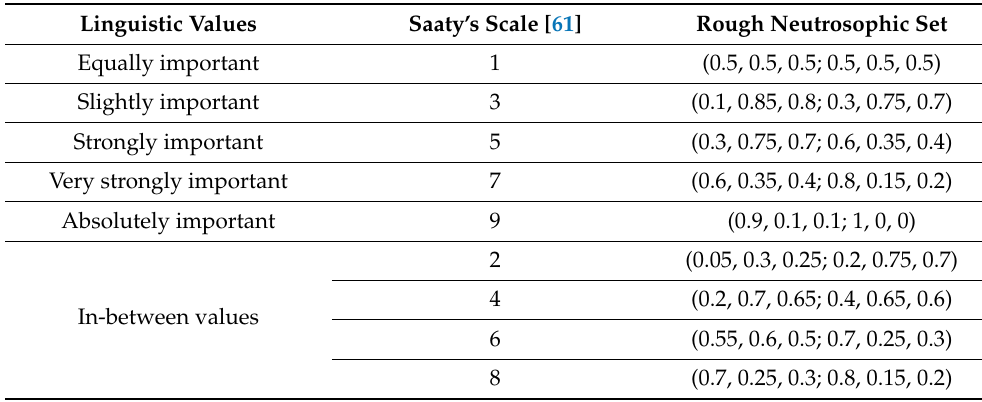
Table 2. Linguistic values and rough neutrosophic set for criteria